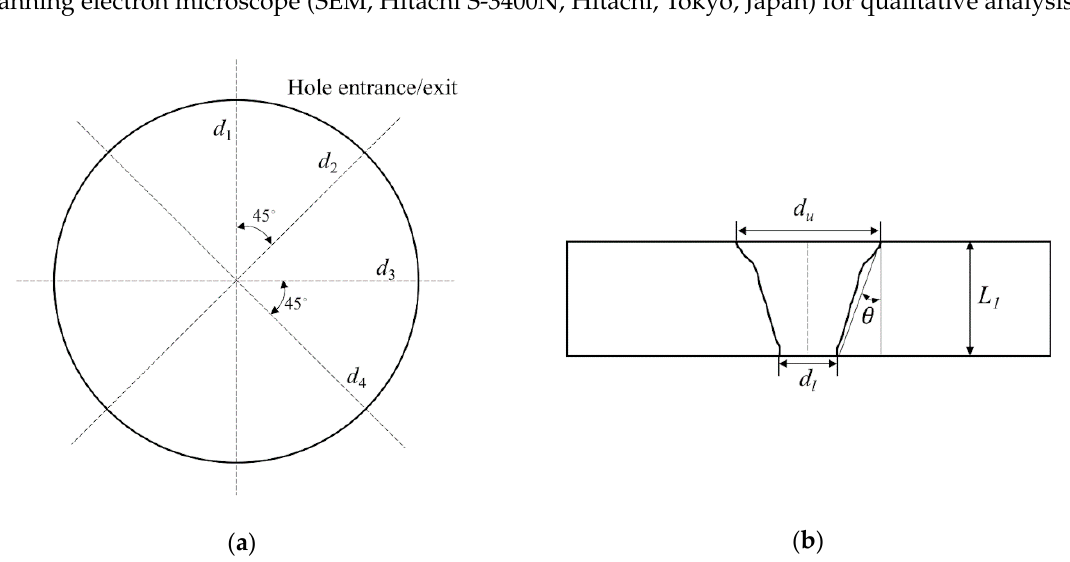
Figure 3. Schematics of ( a ) diameter measurement at the entrance and exit of the trepanning result, and ( b ) hole taper estimation.